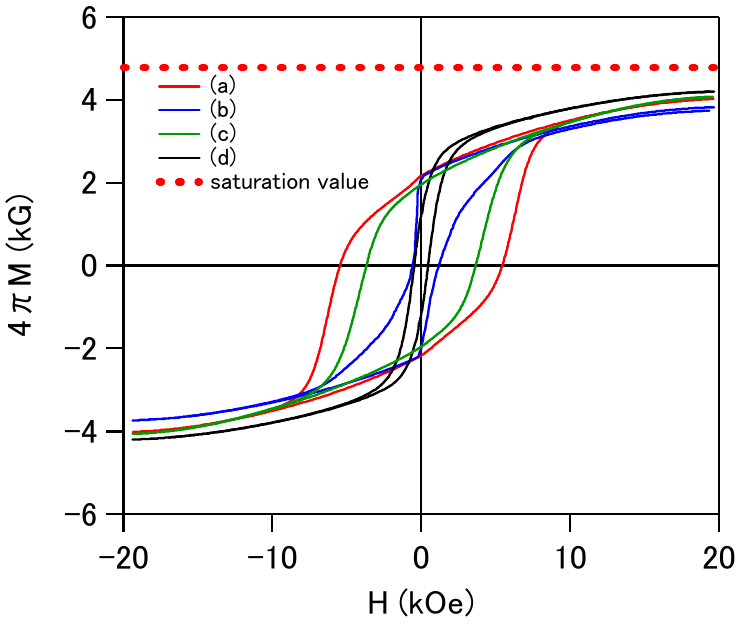
Figure 3. Magnetic hysteresis loops of powder forms of the specimens sintered at: (a) 800 °C, (b) 1000 °C, (c) 1200 °C and (d) 1400 °C.